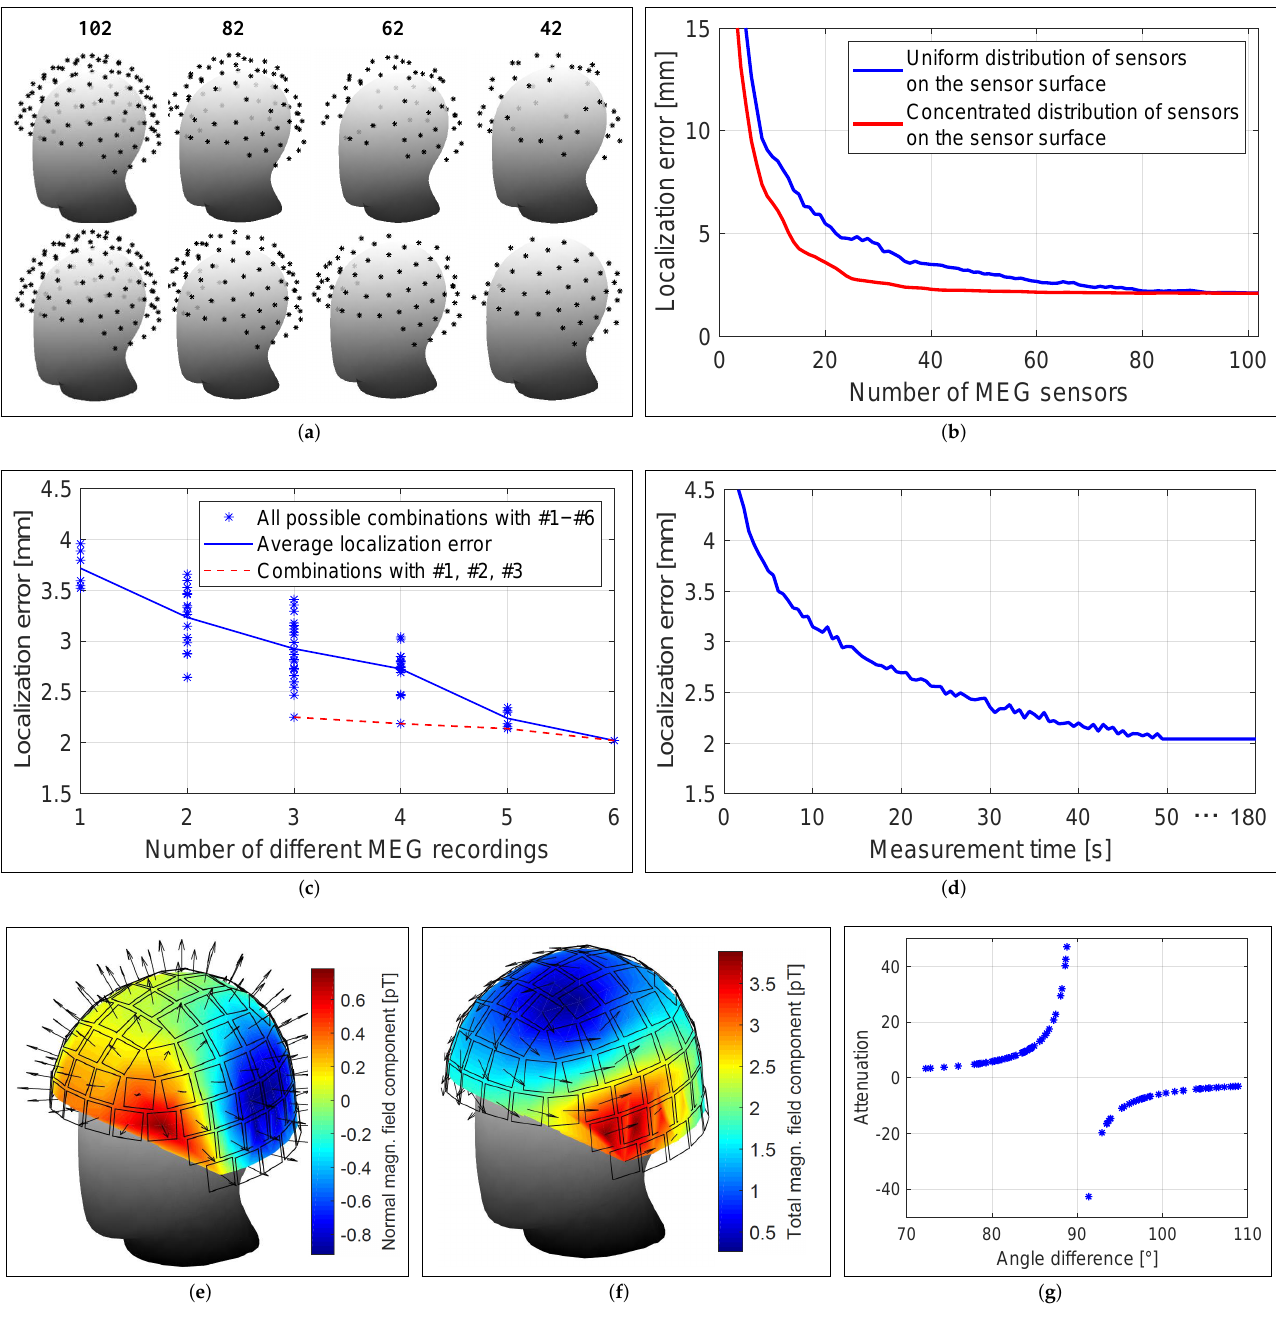
Figure 11. ( a ) Distribution of different numbers of MEG sensors on the sensor surface. Localization error as a function of ( b ) the number of MEG sensors and their distributions, ( c ) the number of MEG recordings with different non-directional stimulation modes, and ( d ) the recording time for each measurement. ( e ) Measured magnetic field distributions with a non-directional stimulation configuration. Arrows indicate the orientation of the MEG sensors. ( f ) Expected magnetic field distribution for the magnitude of the magnetic field. Arrows indicate the direction of the magnetic field. ( g ) Attenuation of measured magnetic fields due to the angle between the orientation of the MEG sensor and that of the magnetic